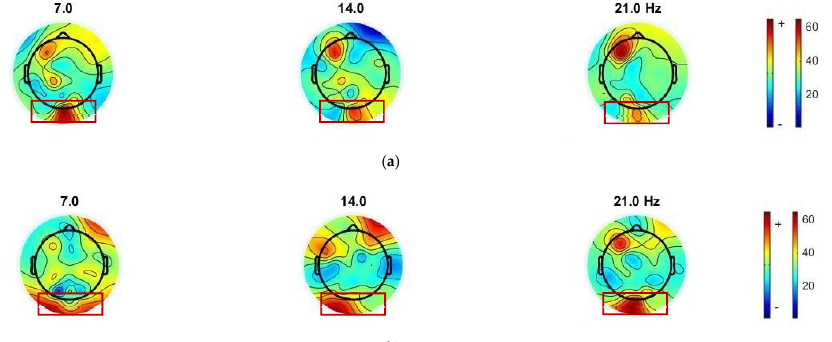
Commented [Ma5]: All highlight Figures: Please change hyphen (-) to minus ( − ) in the picture, please check and revise.